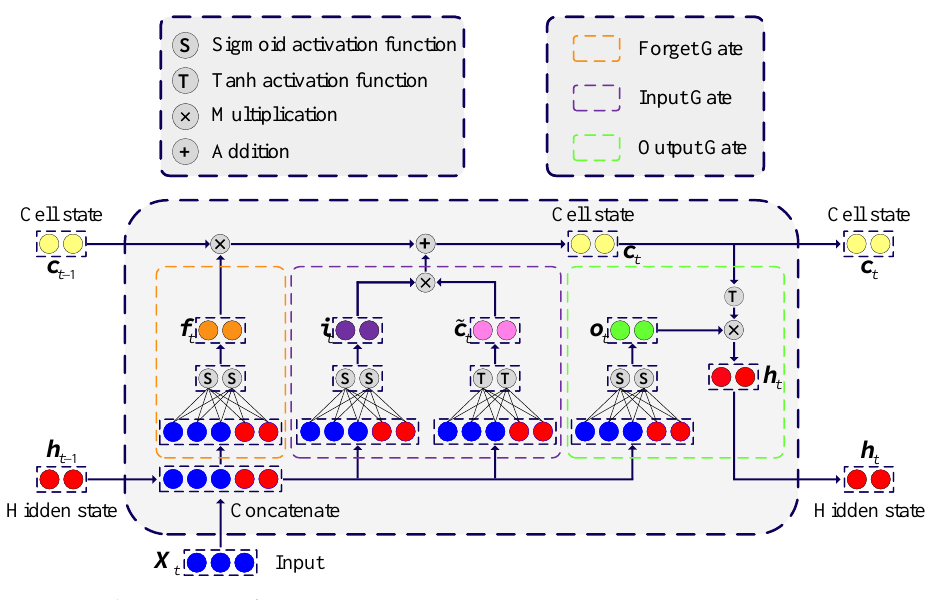
Figure 2. The structure of